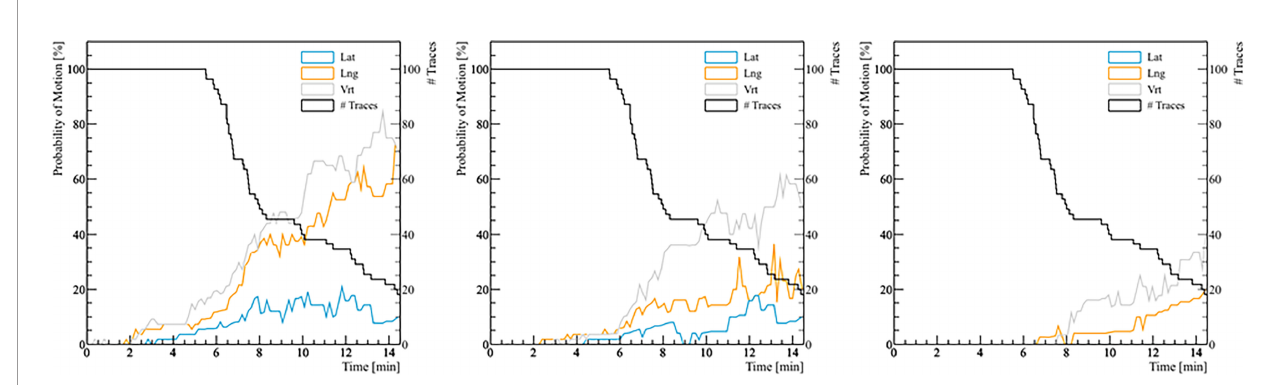
FIGURE 4 | The probability of real prostate motion with no interruptions and patient position corrections as a function of time. The left panel shows the probability of motion > 2 mm, the middle panel for motion > 3 mm, and the right panel for motion > 5 mm. The black line represents the number of traces analyzed with respect to treatment time.